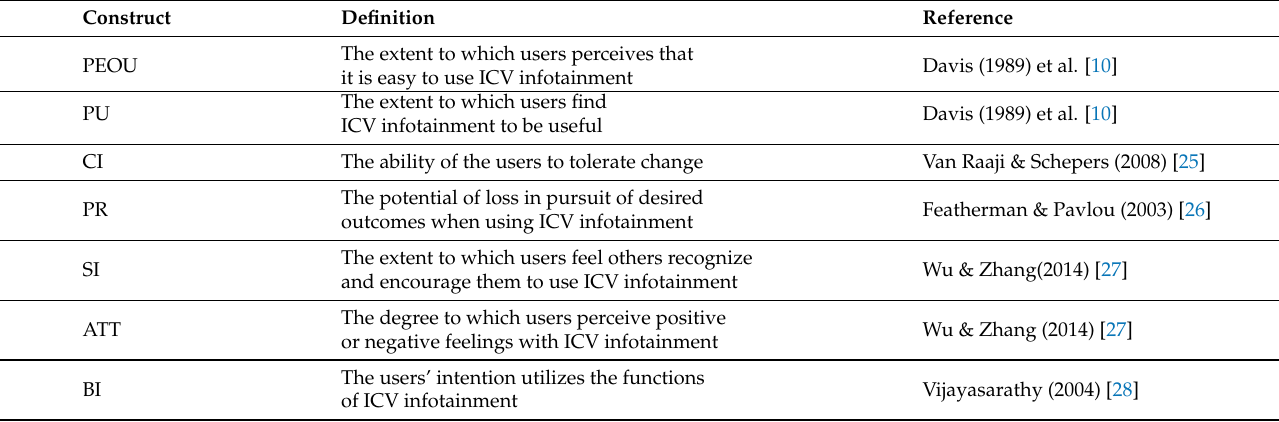
Table 2. Construct definition and